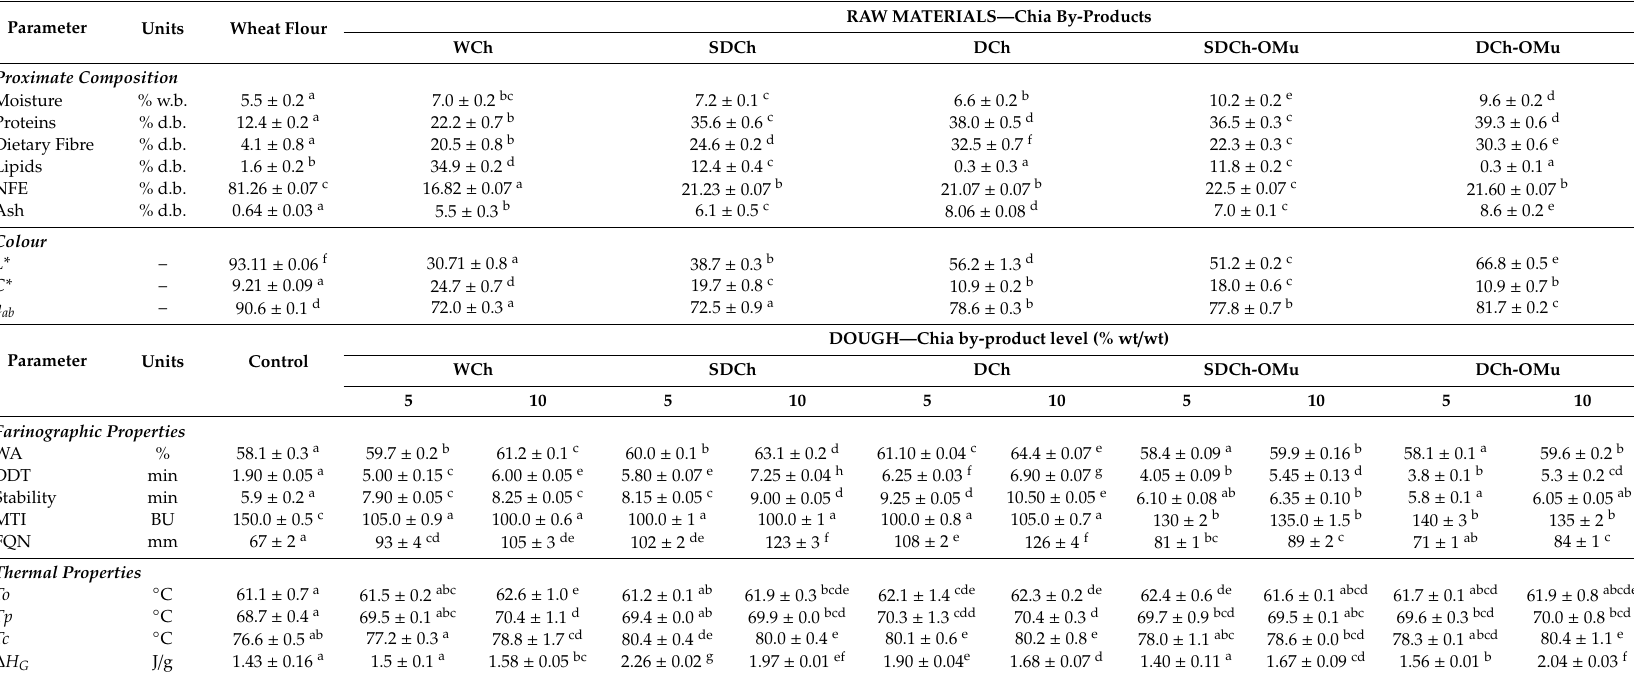
Mean values ± standard deviation (n = 3). Values followed by di ff erent letters di ff er at p ≤ 0.05, according to Tukey test. WCh: Whole chia flour; SDCh: semi-defatted chia flour with mucilage; DCh: defatted chia flour with mucilage; SDCh-OMu: semi-defatted chia flour without mucilage; DCh-OMu: defatted chia flour without mucilage; w.b.; wet basis¸d.b.: dry